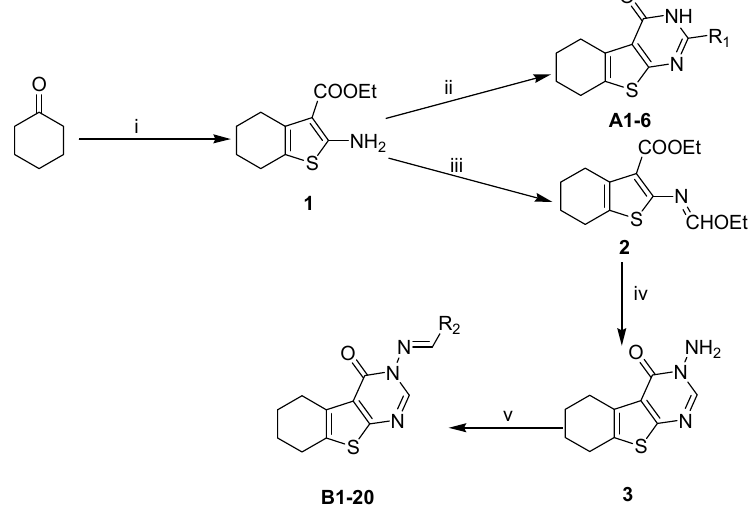
Scheme 2. Synthesis of target compounds. Conditions: ( i ) S, Et 2 NH, EtOH, NCCH 2 COOEt; ( ii ) R 1 CN,